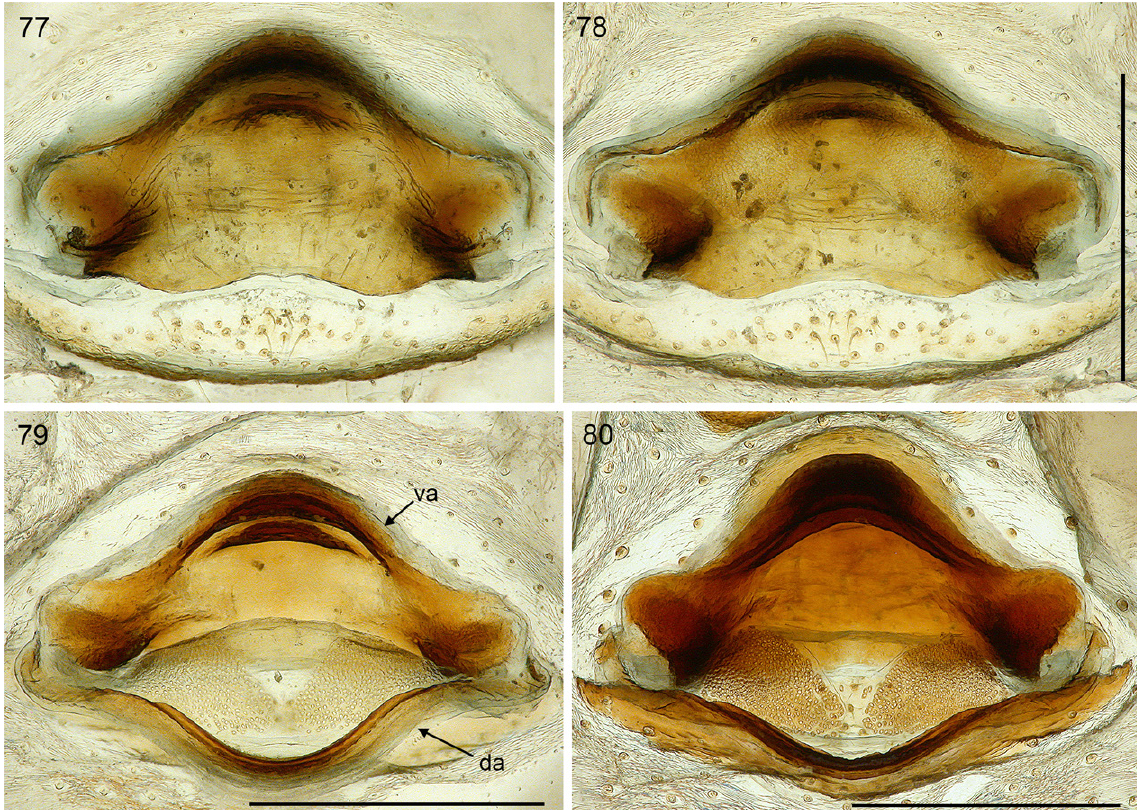
Figs 77–80. Holocnemus reini (C. Koch, 1873) comb. nov. 77–79 . Female from Morocco, Al Kamoun (CAS 9027140); internal genitalia, ventral view, regular dorsal view, and dorsal view with dorsal arc tilted backwards. 80 . Female from Morocco, near Tilamizene (ZFMK 22319); internal genitalia, dorsal view with dorsal arc tilted backwards. Abbreviations: da = dorsal arc; va = ventral arc. Scale bars = 0.5